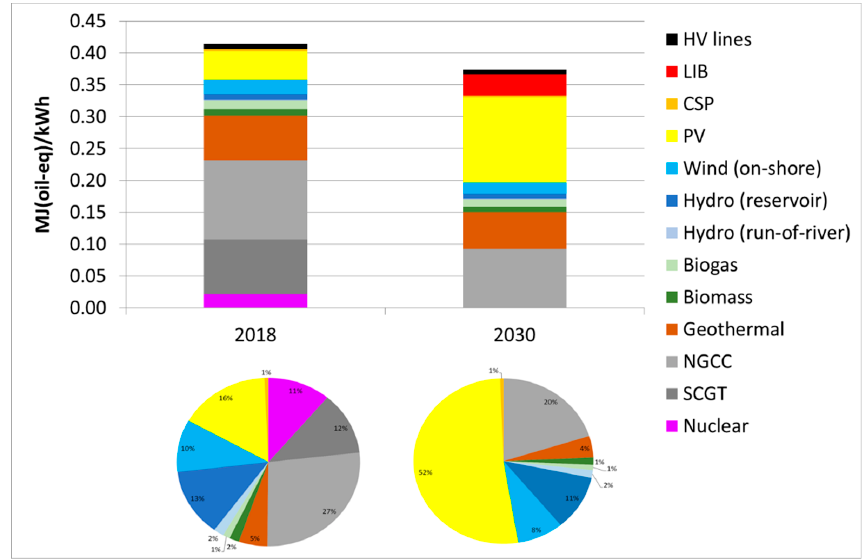
Figure 10. Primary energy investment results for California domestic grid mix in 2018 and in 2030. The pie charts underneath each bar refer to the corresponding grid mix composition, and are included to aid the interpretation of the results. SCGT = single cycle gas turbines; NGCC = natural gas combined cycles; PV = photovoltaics; CSP = concentrating solar power; LIB = lithium-ion batteries; HV = high voltage.